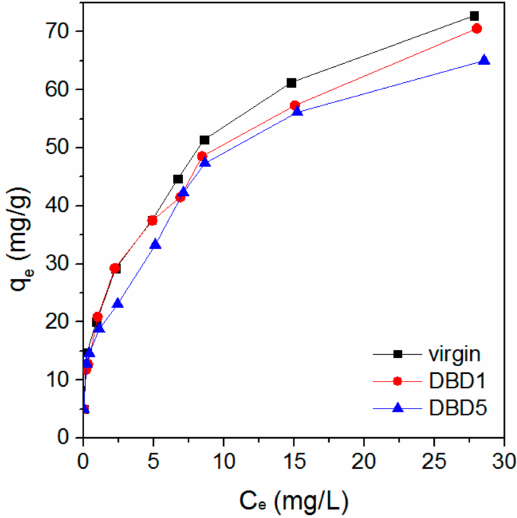
Figure 2. Adsorption isotherms of indigo carmine on virgin and different saturated/DBD regeneration resins.